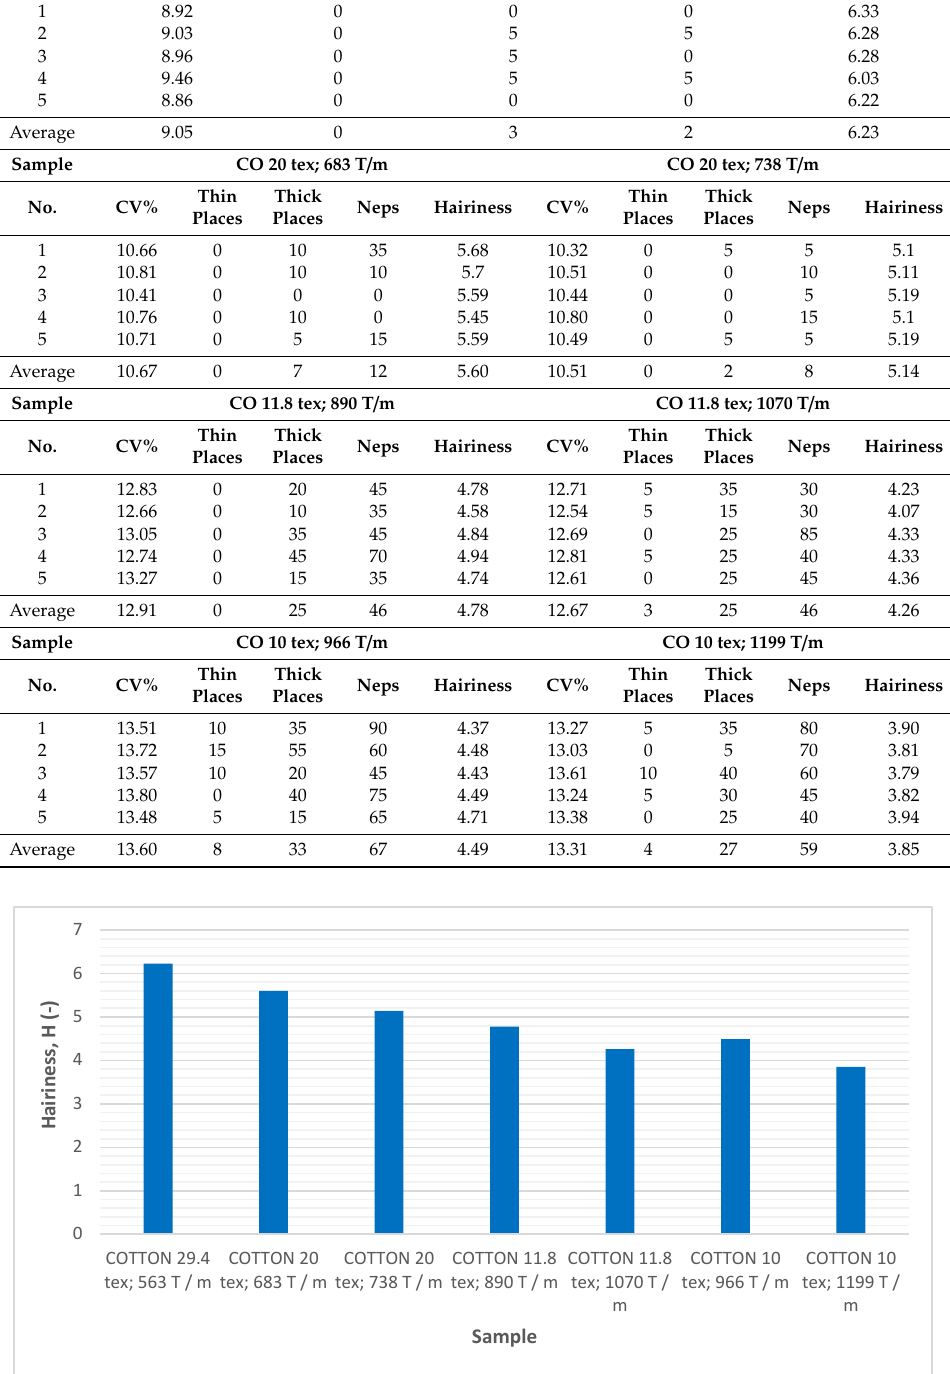
Figure 6. Average hairiness of the analyzed yarns.